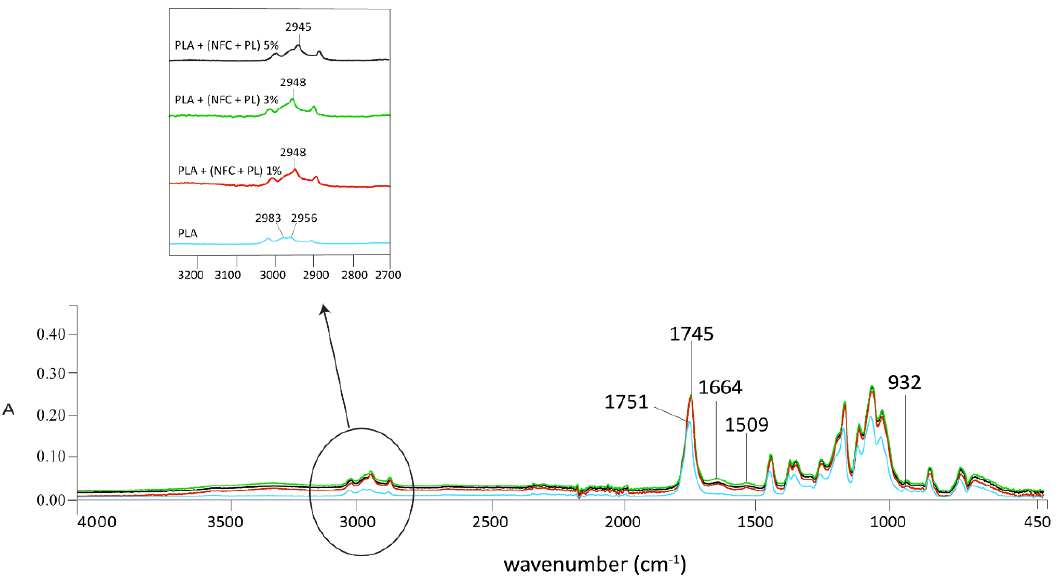
Figure 7. FTIR spectra of GR3 samples at wavenumbers of 4000–450 cm − 1 .